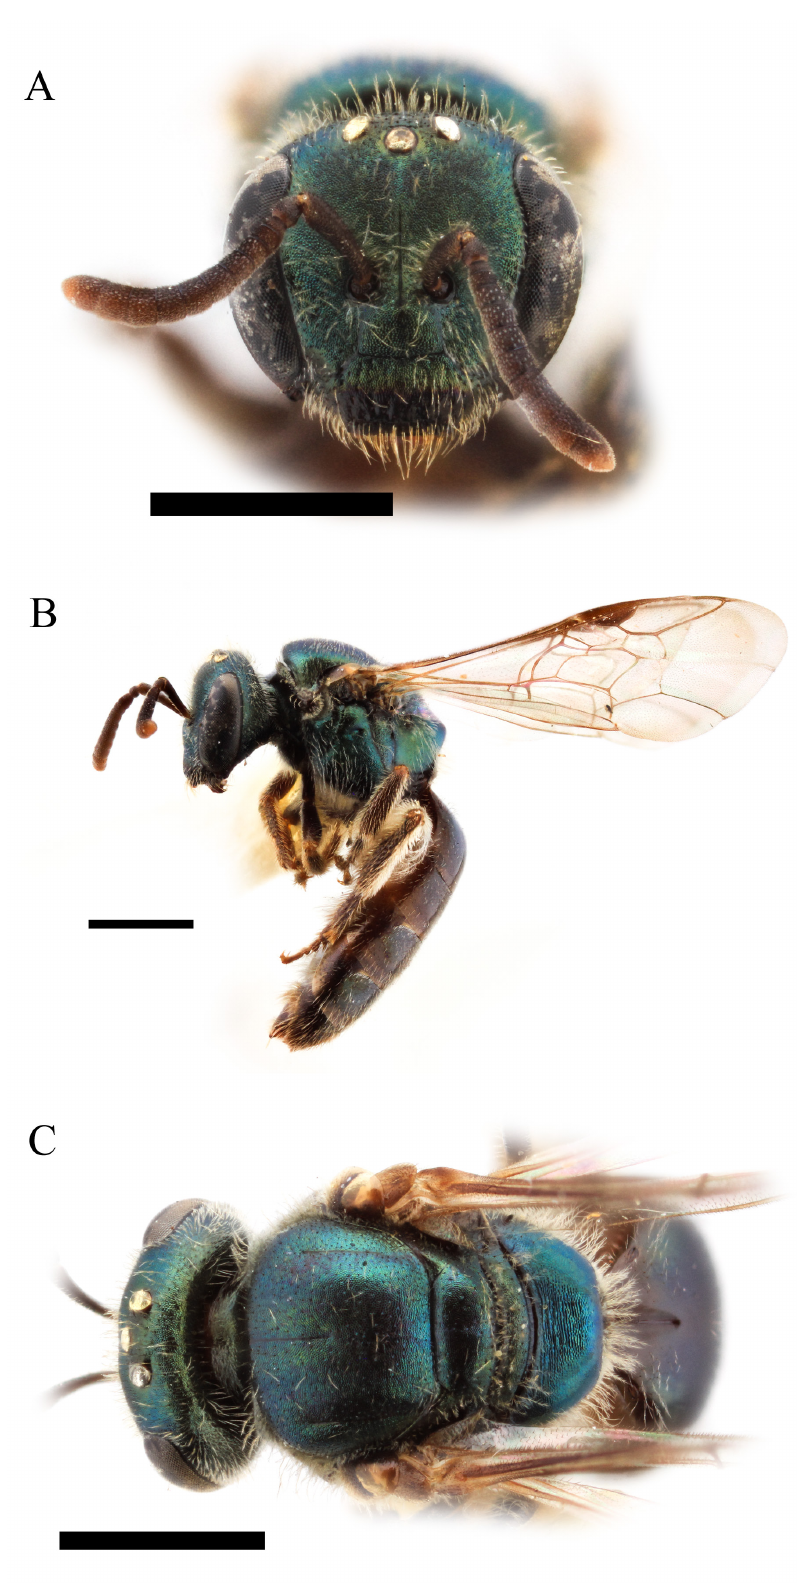
Fig. 8. Lasioglossum ( Habralictellus ) roseauense sp. nov. Holotype, ♀. A . Face. B . Lateral habitus. C . Dorsum of mesosoma. Scale bars = 1